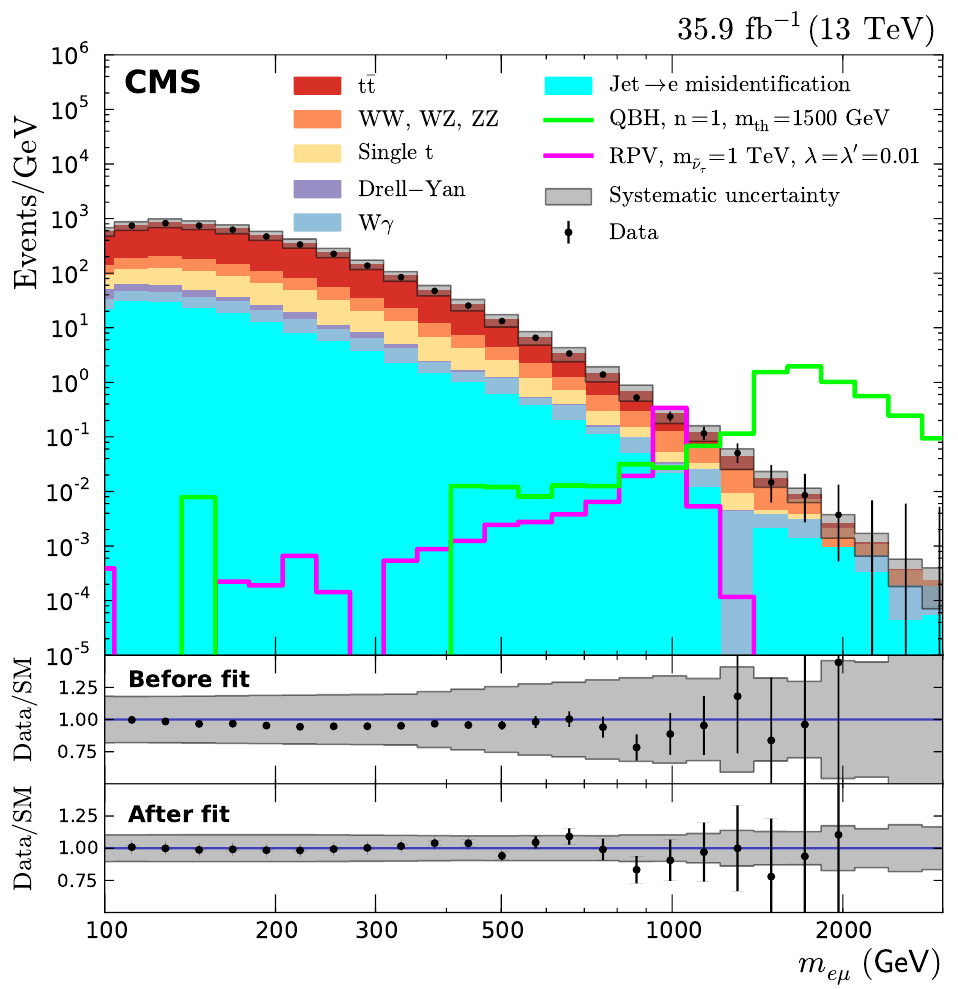
Figure 6 . Invariant mass of the e (cid:22) pair for all events that pass the event selection criteria. In the lower panels, we show the ratio of the data to the before-(cid:12)t and after-(cid:12)t background predictions, including uncertainties. The label (cid:21) stands for (cid:21) 132 = (cid:21) 231 , while (cid:21) 0 stands for (cid:21) 0 is the same as in (cid:12)gure 2, but with a coarser